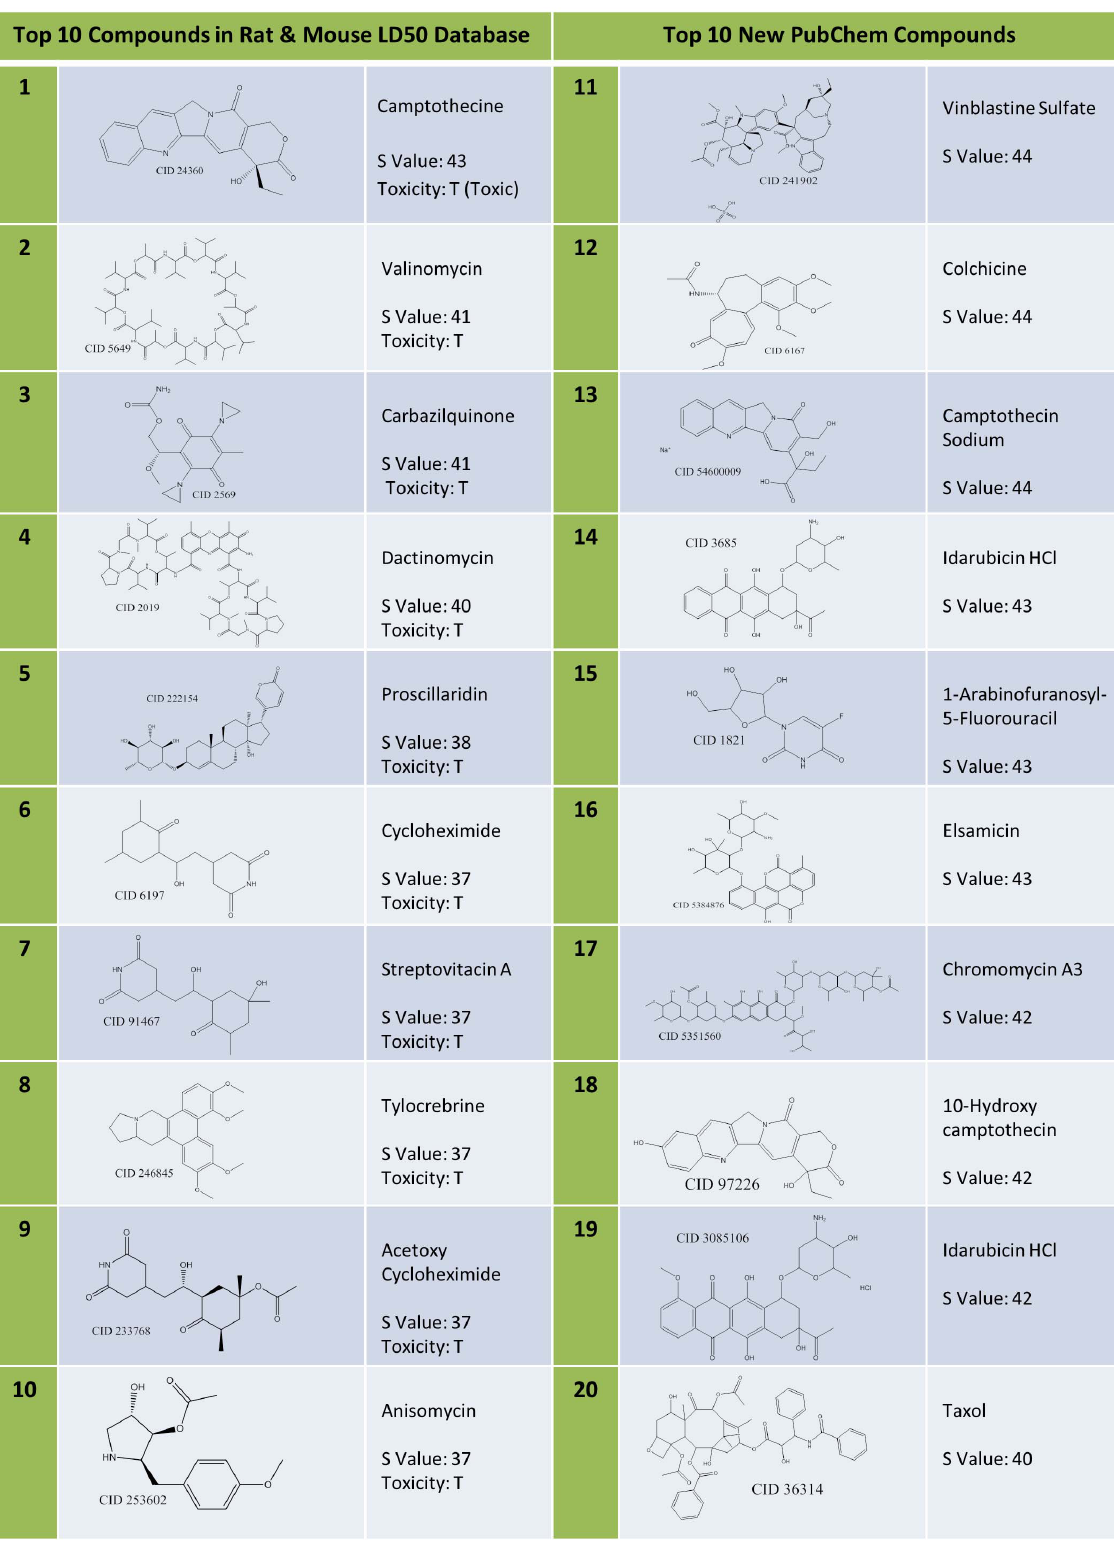
PLOS ONE | www.plosone.org 8 June 2014 | Volume 9 | Issue 6 |